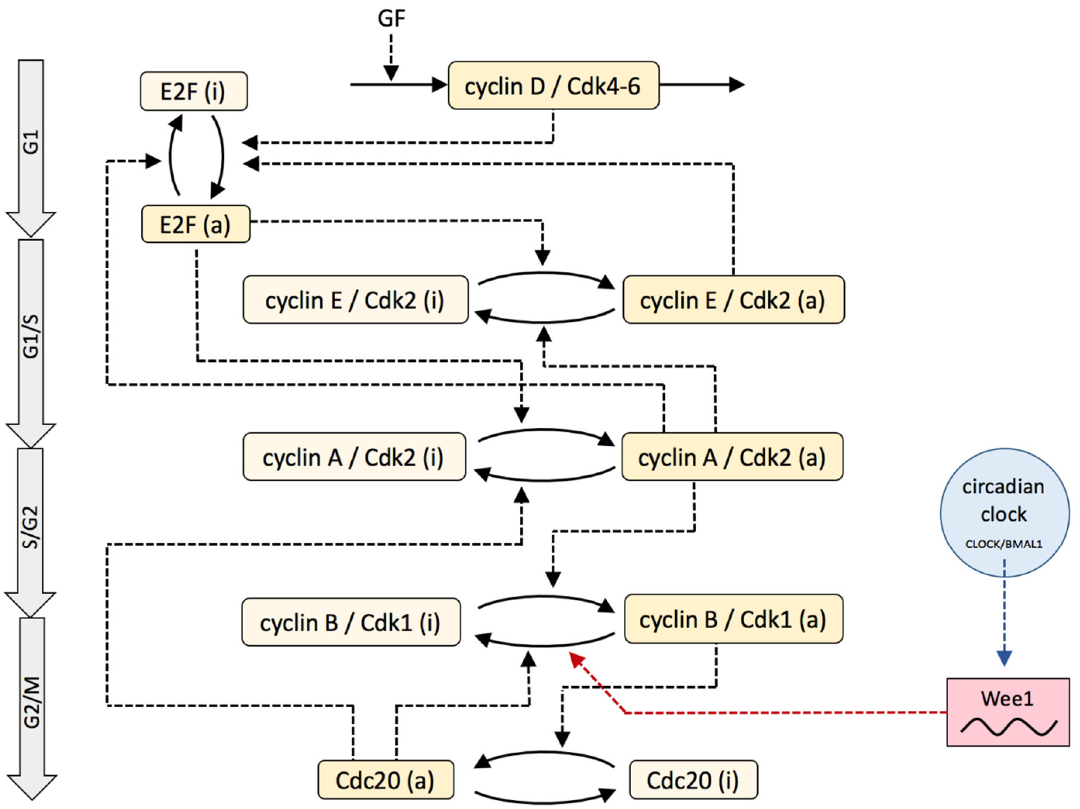
Figure 1. Scheme of the cell cycle model. The model describes the dynamics of the four main cyclin/Cdk complexes, the transcription factor E2F, and the protein Cdc20 [33]. Solid arrows denote synthesis/degradation of the cyclin D/Cdk4-6 complex and activation/deactivation of the other complexes. Dashed arrows indicate the regulations. The dynamics of Wee1, whose the synthesis is controlled by the circadian clock, is described by a 24 h period sine function. Wee1 induces the deactivation of the cyclin B/Cdk1 complex.